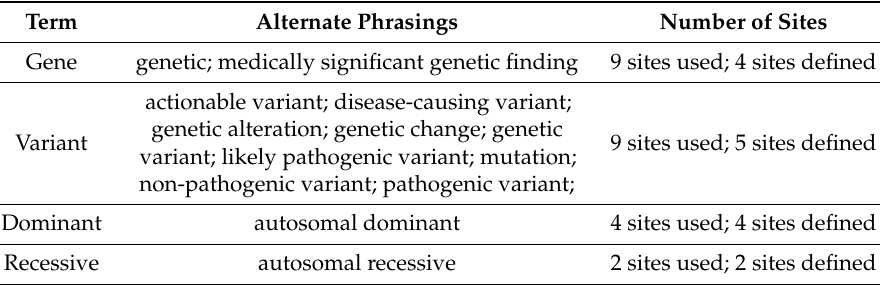
Table 2. Frequency of appearance and definition of key